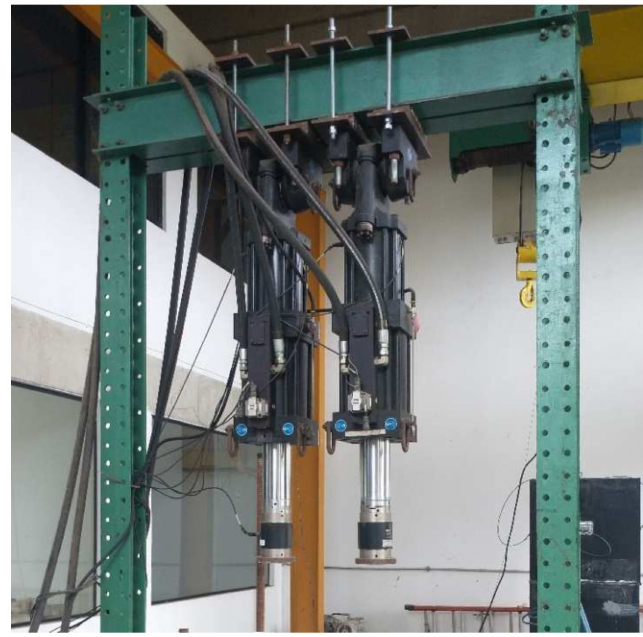
Figure 9. Hydraulic press for applying the load.